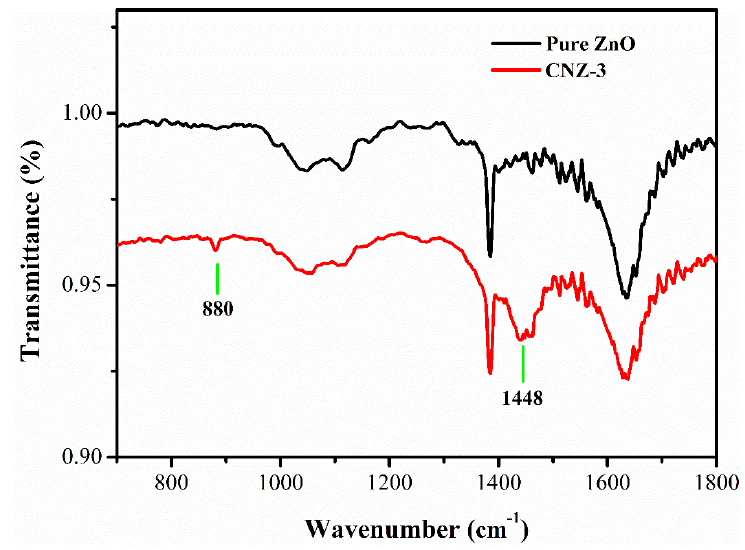
Figure 5. FTIR spectra of the pure ZnO and CNZ-3.